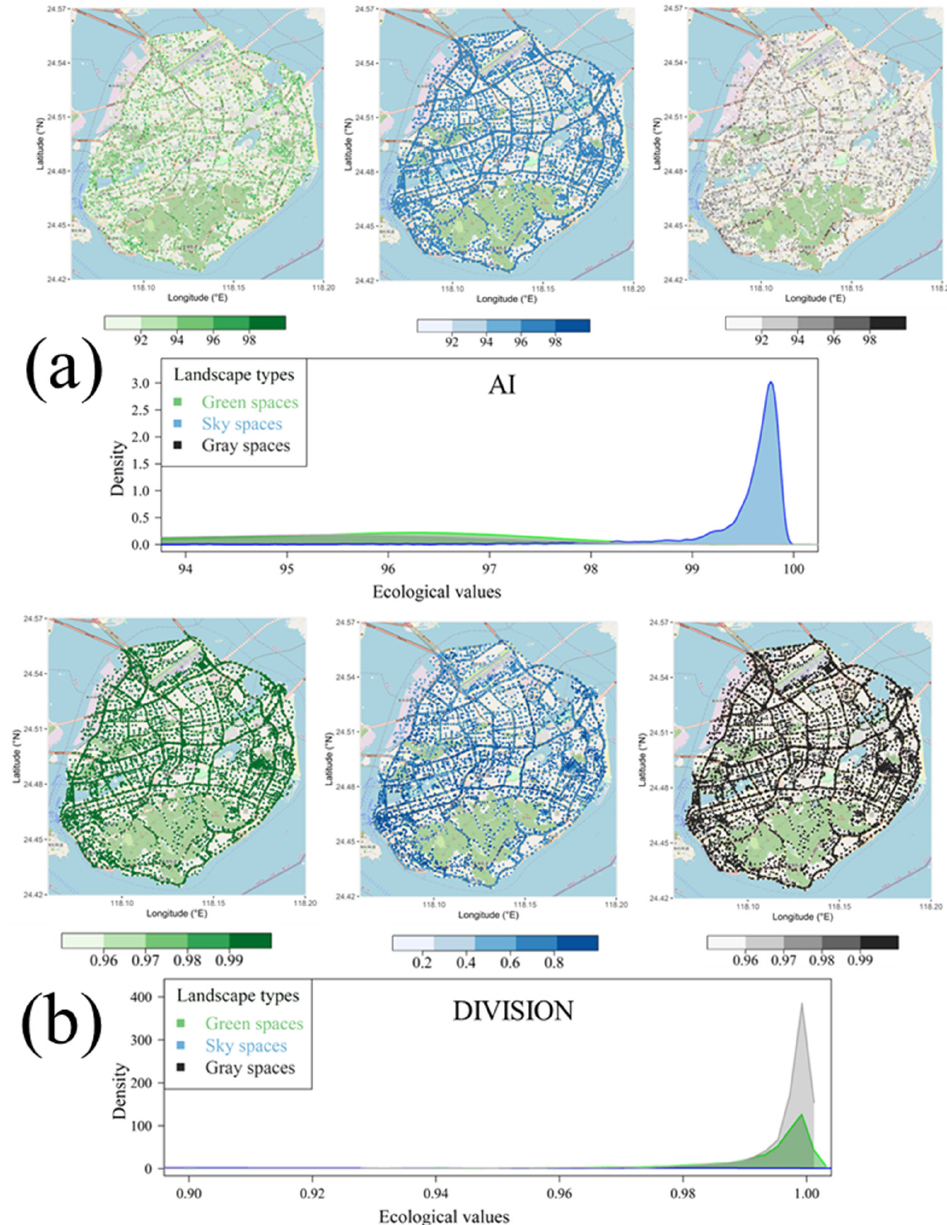
Figure 7. The spatial and density distribution for ecological landscape indicators; ( a ) for AI and ( b ) for DIVISION.